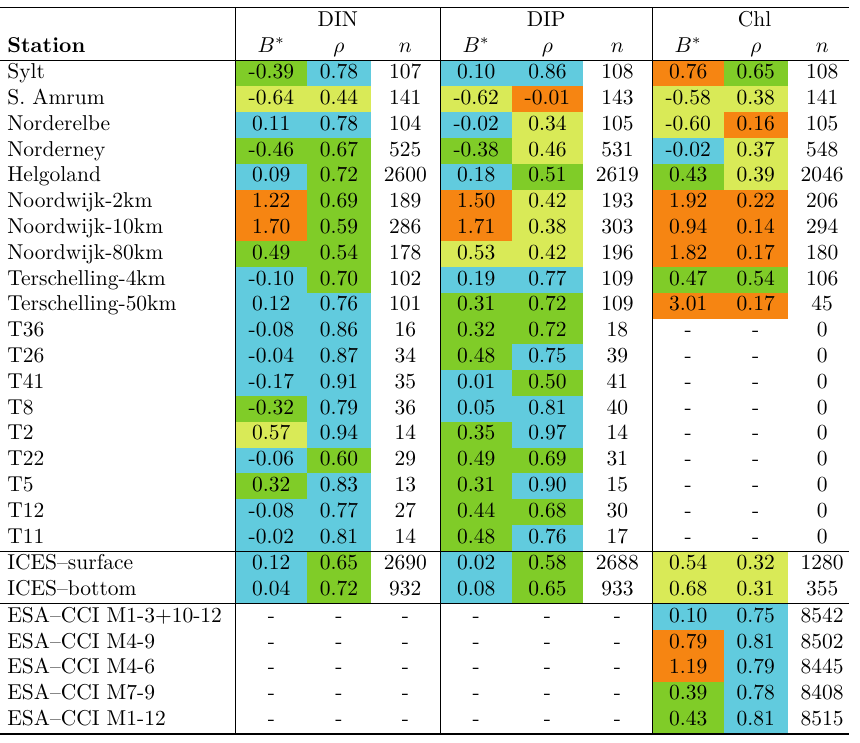
Table 1. Skill scores obtained at each station ( B ∗ is the normalized bias, ρ is the Pearson correlation coefficients and n is the number of matching data points) against ICES and ESA-CCI data shown in Figs. 5–8 and Fig. 12 partially (for the averages of months 1–3, 10–12 and 4–9). Colors indicate skill level, with red being low, yellow being moderately low, green being moderately high and blue being high (see Sect.